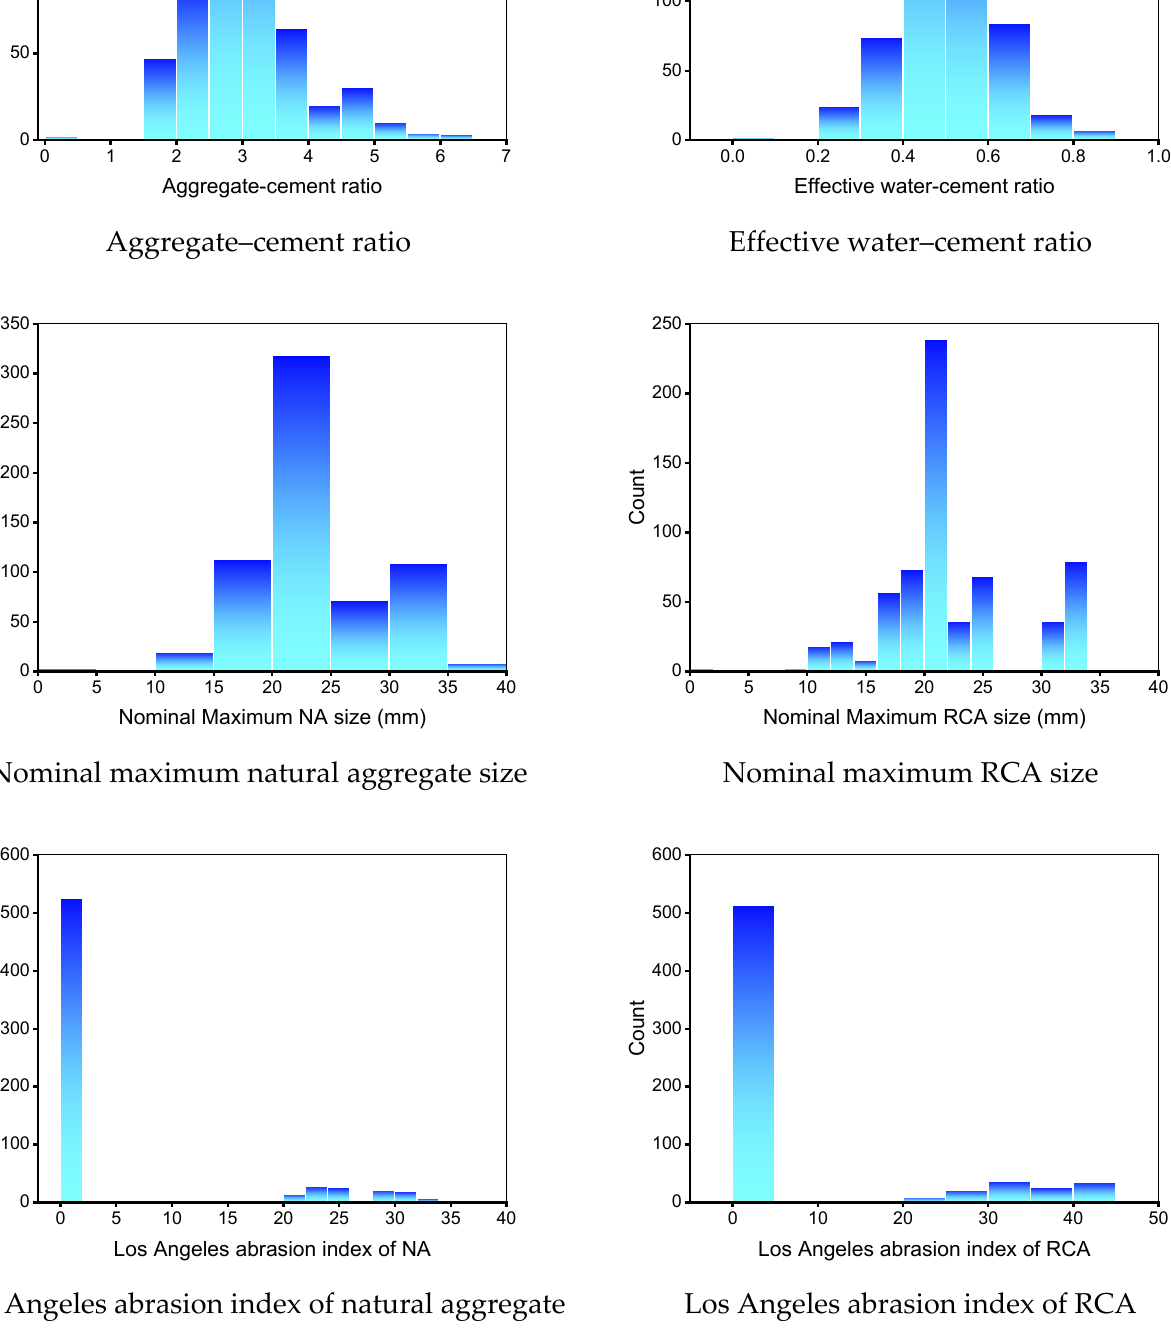
Figure 1. Relative frequency dispersal of input parameters for the compressive strength dataset. NA: natural aggregate, RCA: recycled concrete aggregate.